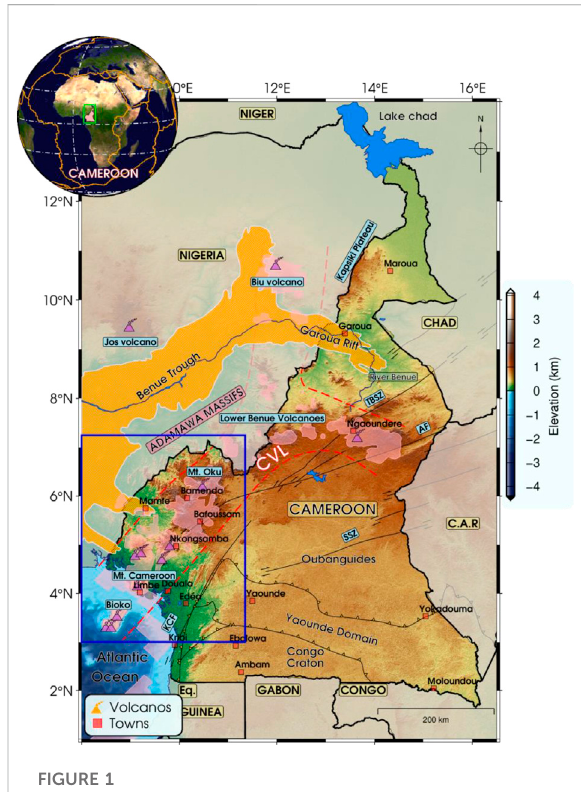
FIGURE 1 Map location of the study area with the representation of the Cameroon Volcanic